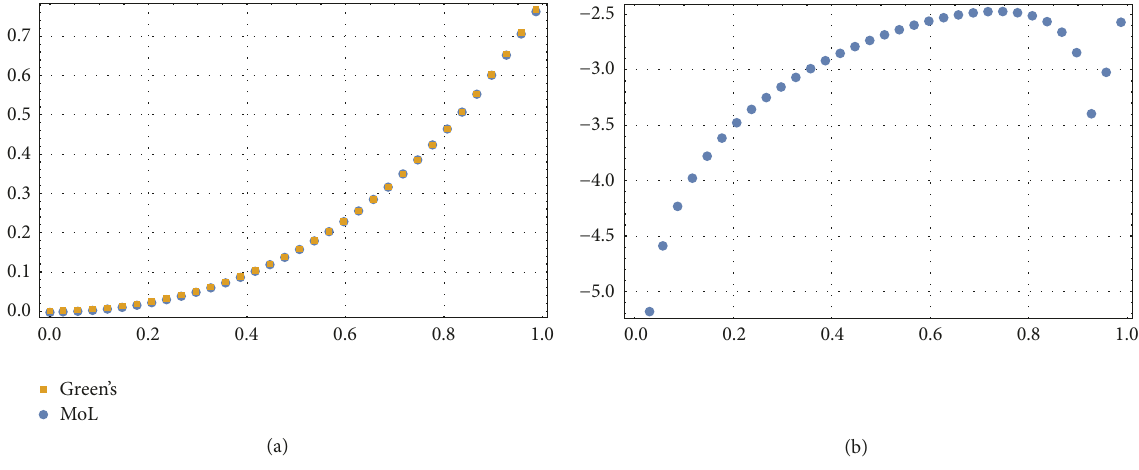
Figure 5: Discrete plot of 𝑤 and 𝑤 MoL (a) and Er (b) against 𝑡 ∈ [0, 1] for 𝑓(𝑡) = 1 + 𝑡 + 𝑡 2 + 𝑡 3 : quadratic potential. Green’s